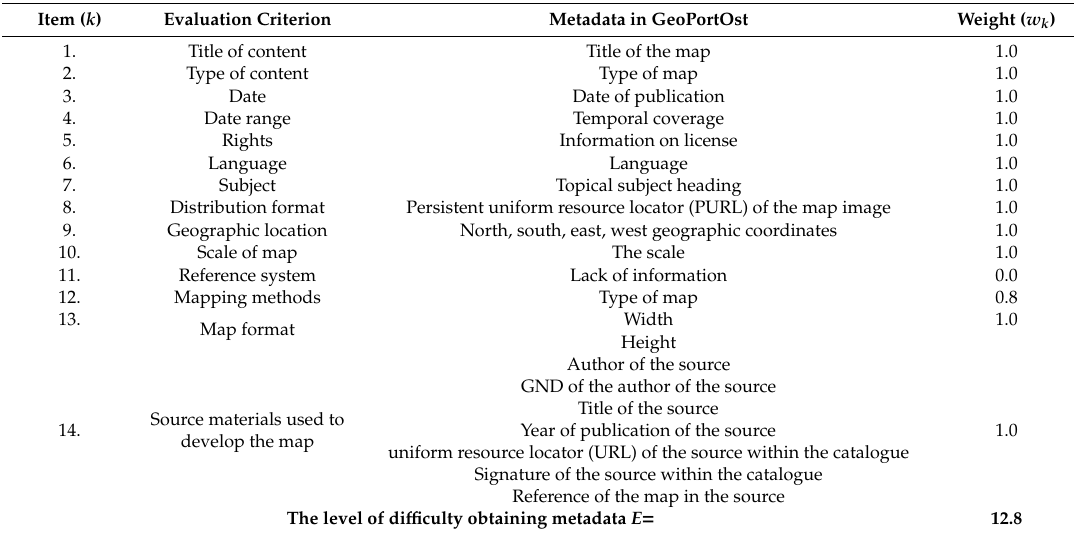
Table 3. Assignment of metadata elements of the analyzed collections to the adopted evaluation